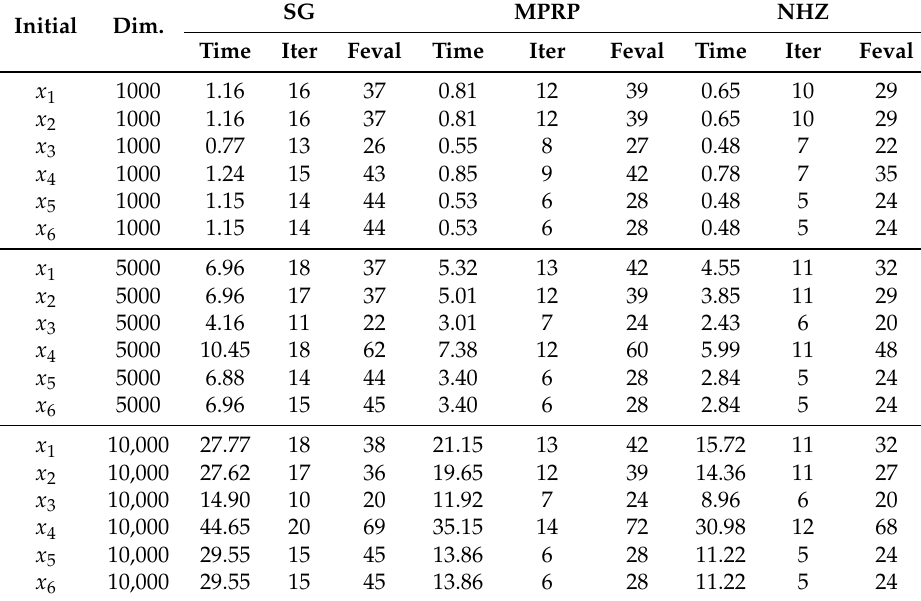
Table 1. Numerical results for the tested Problem 1 with various sizes and given initial points. Initial